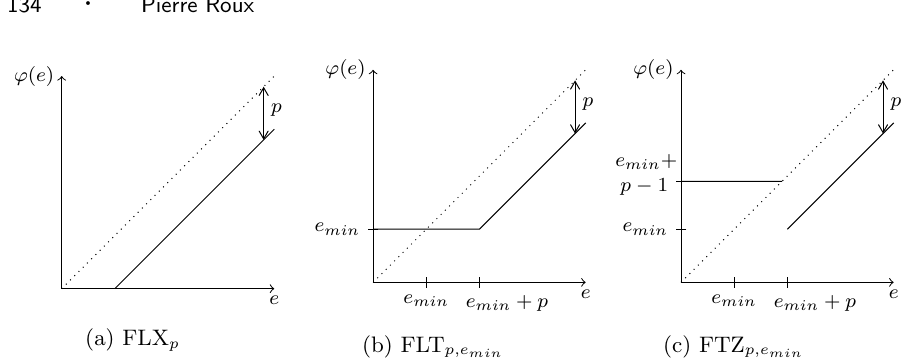
Fig. 1: Illustration of the functions ϕ defining the formats FLX, FLT and FTZ. The difference ( e − ϕ ( e )) between the diagonal (doted line) and the graph of ϕ is the size of the mantissa for numbers of magnitude e in format F ϕ (if non positive, numbers can only be encoded as 0). These functions are the same for normal numbers ( e ≥ e min + p ) and only differ for subnormal numbers. FLX doesn’t model them while FLT has gradual underflow and FTZ abrupt